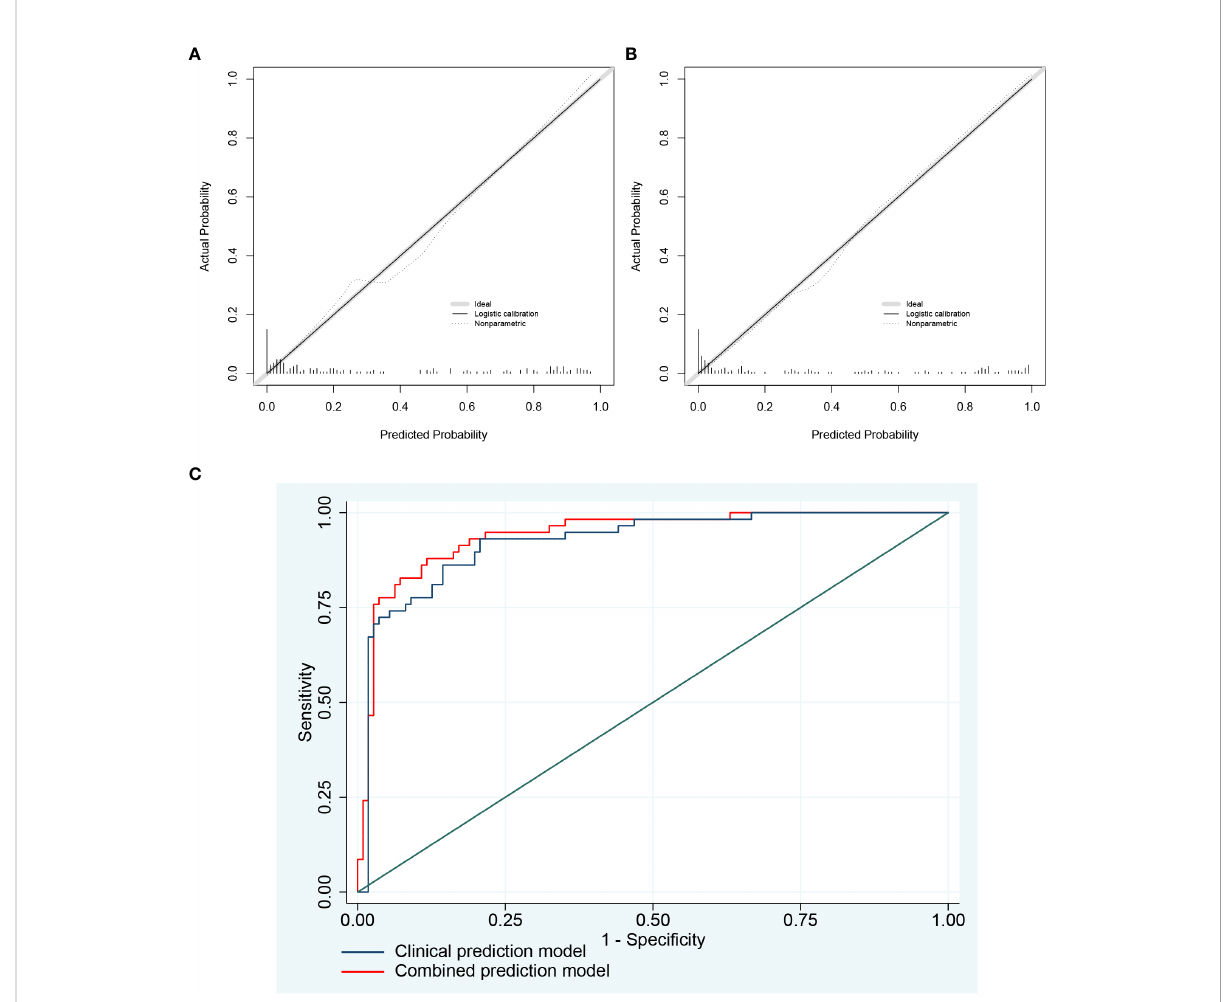
FIGURE 11 The calibration plots and ROC curves of two prediction models. (A) The calibration plots of the clinical prediction model; (B) The calibration plots of the combined prediction model. As shown by the nonparametric line, the predicted probability of the combined prediction model is closer to the actual probability compared with the clinical prediction model. (C) The ROC curves of two prediction